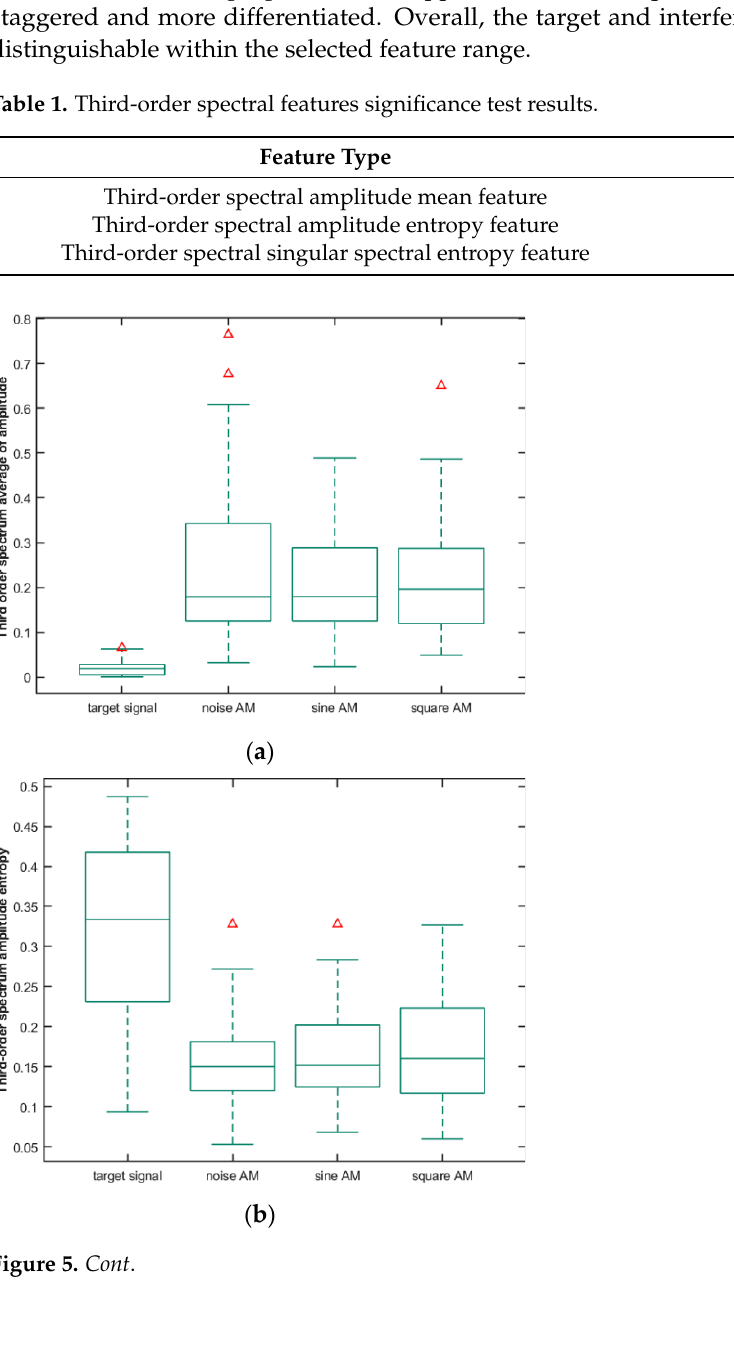
( c ) Figure 5. Box diagram of different signal features. ( a ) Box diagram of three order spectrum average amplitude feature; ( b ) Box diagram of three order spectrum entropy feature; ( c ) Box diagram of three order spectrum singular spectrum entropy feature. The scatter plot of the three-dimensional characteristics of the target and interference signals is shown in Figure 6, where the red circles indicate the target signals and the other graphs indicate different interference signals. It can be seen from the figure that the vast majority of the target and interference signals in the three-dimensional feature space do not overlap with the interference signals in the scatter plot, and only a very small number